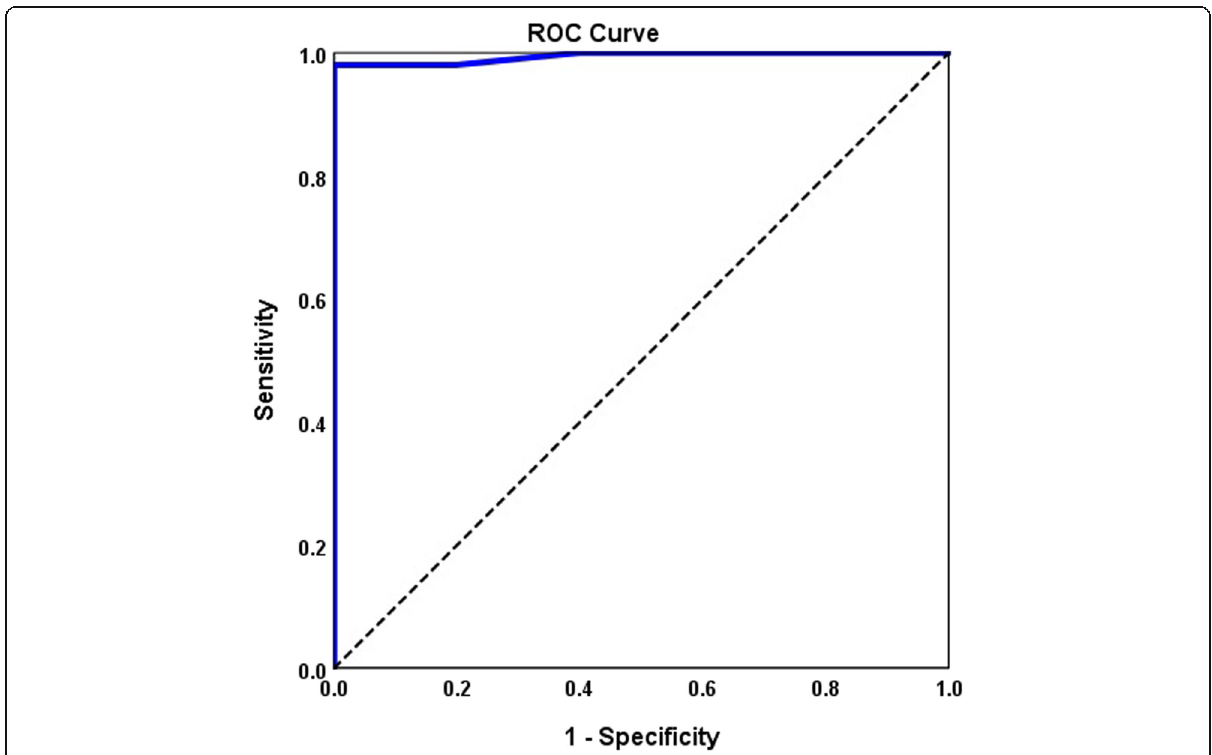
Fig. 5 ROC curve analysis to explore the discriminant ability of mean ADC value to differentiate (grade III) from (grades I and II)